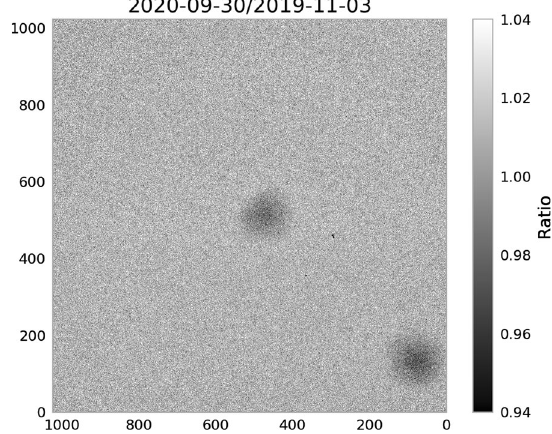
Fig. 4 Dark areas are emphasized by taking the ratio of the FF-lamp image taken on September 30, 2020, in which the dark areas appeared, and the FF-lamp image taken on November 3, 2019, which was acquired just before departure from